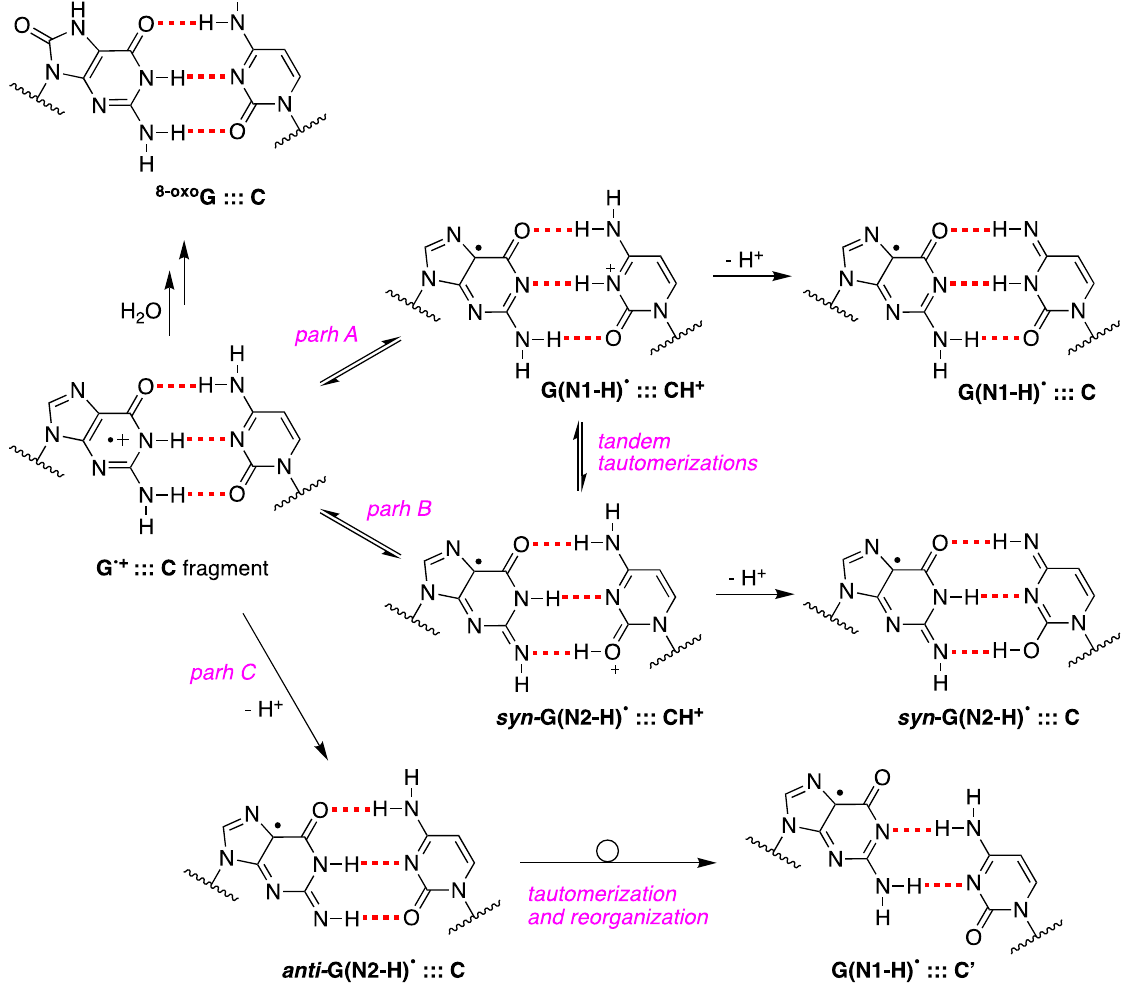
Figure 10. Mechanistic possibilities of G •+ :::C deprotonation in ds-ODNs and its reaction with water to give 8-oxo G:::C.